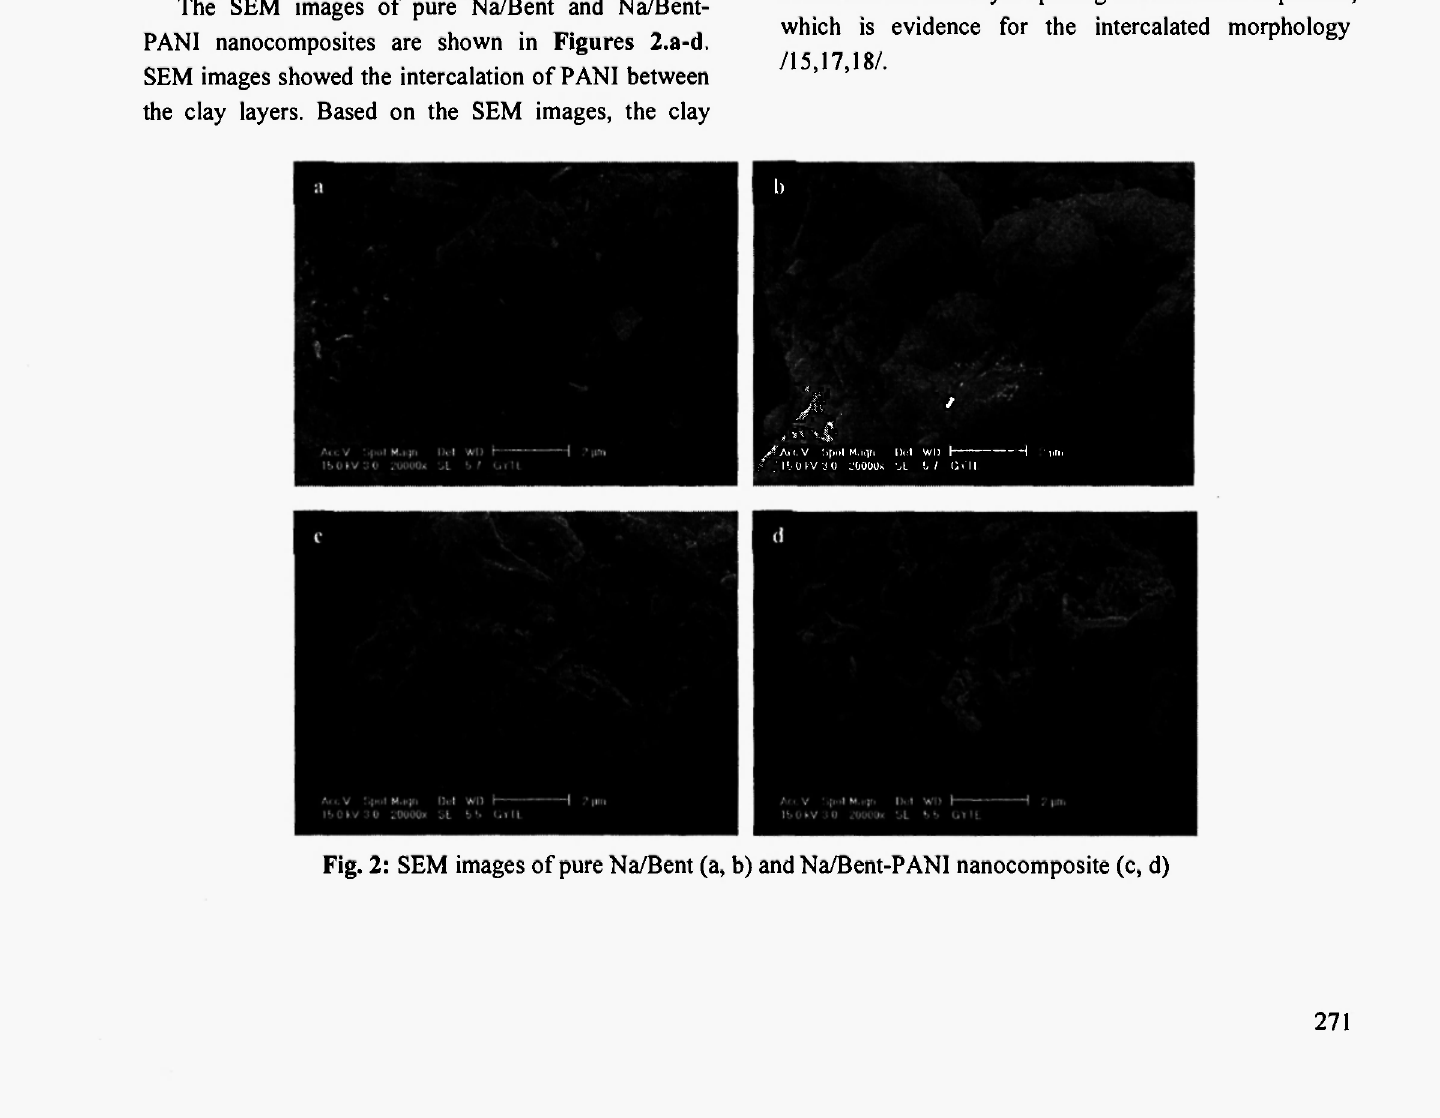
Fig. 1: XRD analysis of Na/Bent-PANI and pure Na/Bent composite